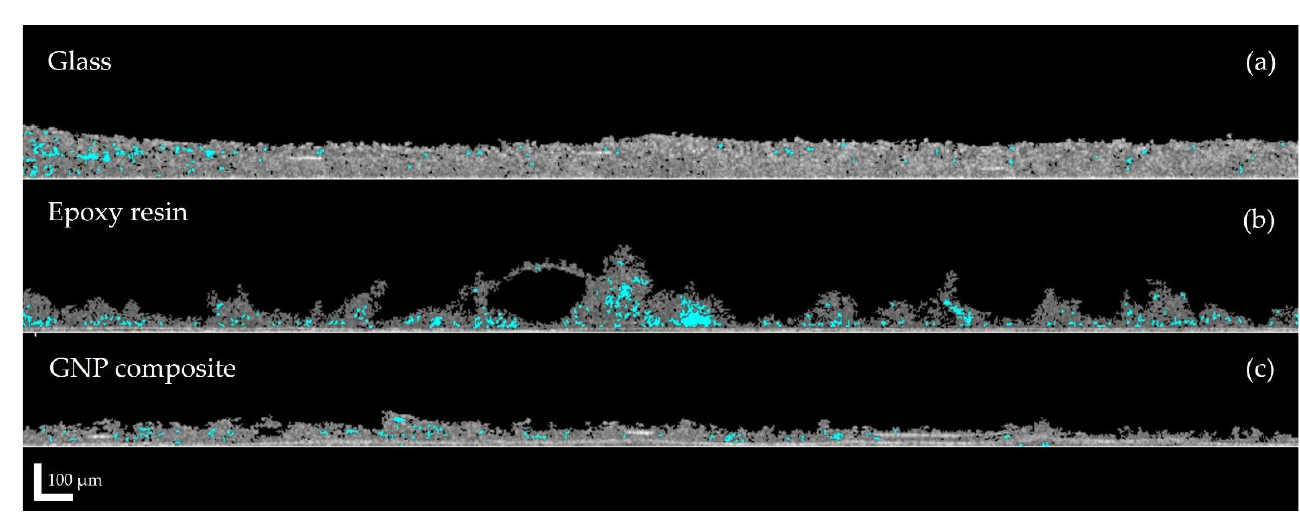
Figure 6. Representative 2D cross-sectional OCT images obtained for Lusitaniella coriacea LEGE 07157 biofilms on glass ( a ), epoxy resin ( b ), and GNP composite ( c ) after 49 days. The empty spaces on the biofilm structure are indicated in blue (scale bar = 100 μm).